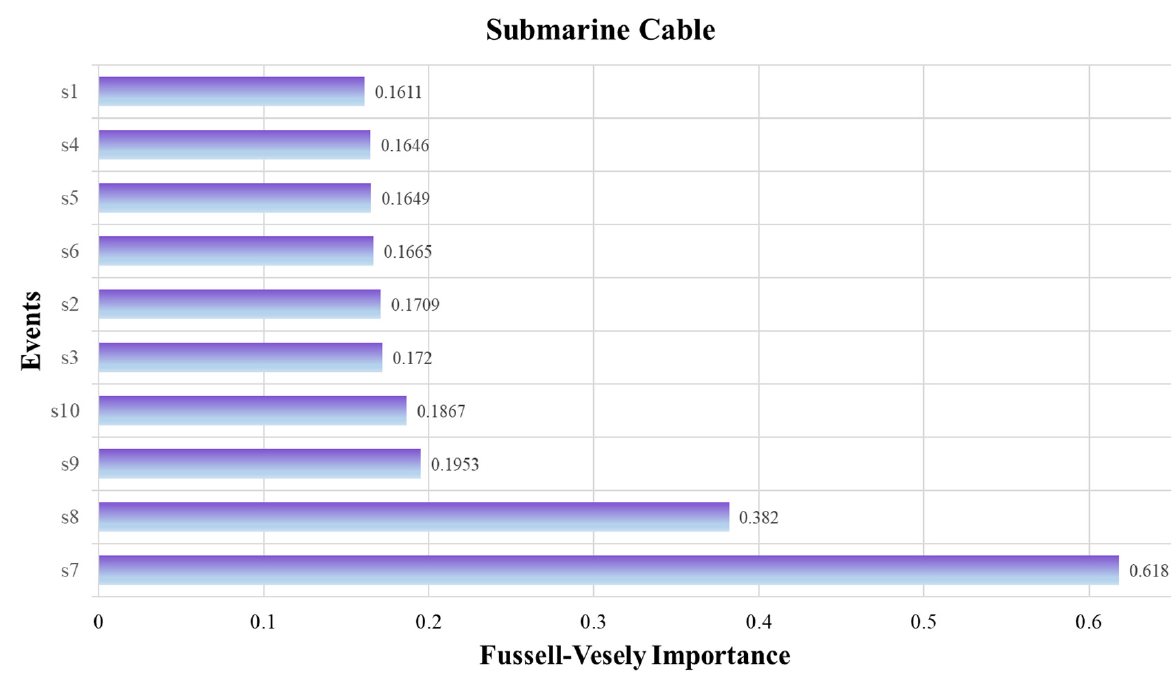
Figure 17. Fussell–Vesely Importance of each basic event of submarine cable accident.